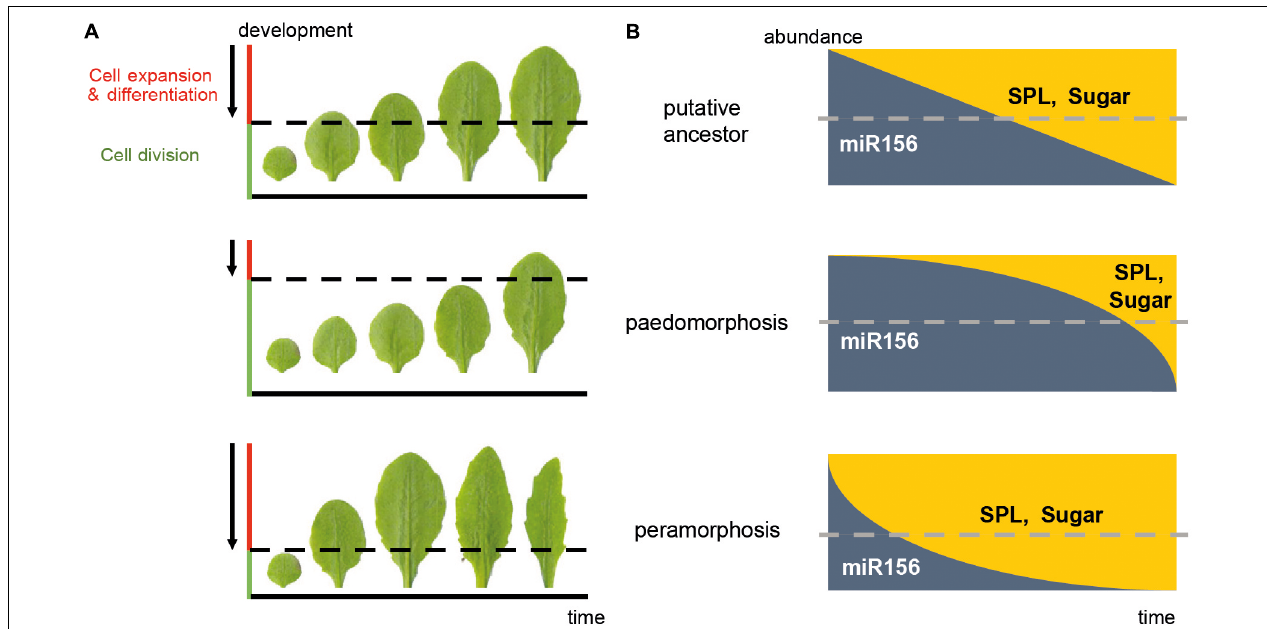
FIGURE 2 | Mechanisms driving heterochrony in plants. (A) Cellular heterochrony. The sequence of rosette leaves produced during vegetative development is shown. The phenotype of Arabidopsis Columbia wild type plants is taken as a hypothetical ancestral state; a paedomorphic scenario (neoteny) and a peramorphic scenario (acceleration) are also shown. Arrows represent the direction of the wave of the cell division arrest in a basipetal gradient, where cells below the dotted line are still actively dividing whereas the cells above are expanding and/or differentiating. (B) Transcriptional and metabolic heterochrony. A graphic representation of the predicted abundance of the microRNA miR156/7 and its targets, the SPL genes, as well as sugar abundance along the time of vegetative development, corresponding to the phenotypes in (A) . Dotted lines represent the threshold of miR156/7 and SPL abundance which leads to juvenility (above the threshold) or adulthood (below the threshold). In this case, a delay in the repression of miR156 and activation of SPL expression and sugar production results in paedomorphosis, whereas a precocious decay of miR156 and early activation of SPL expression and sugar production results in peramorphosis. These drawings are simplified representations, and do not reflect the exact abundances in nature. The actual pattern of miR156/SPL abundance is closer to that depicted for “peramorphosis”